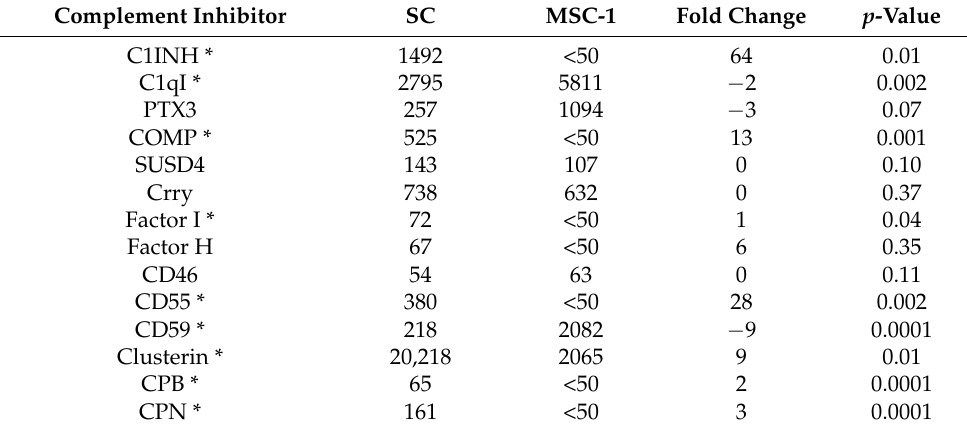
Table 3. Complement inhibitor expression by mouse SCs.